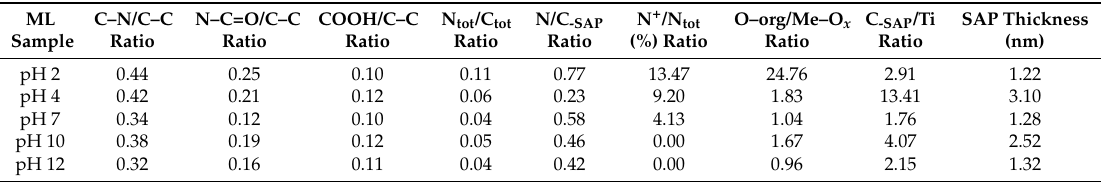
Table 3. Atomic ratios of the species present on ML. N + : protonated nitrogen; Me–O x : oxygen of metal oxides; O–org: organic